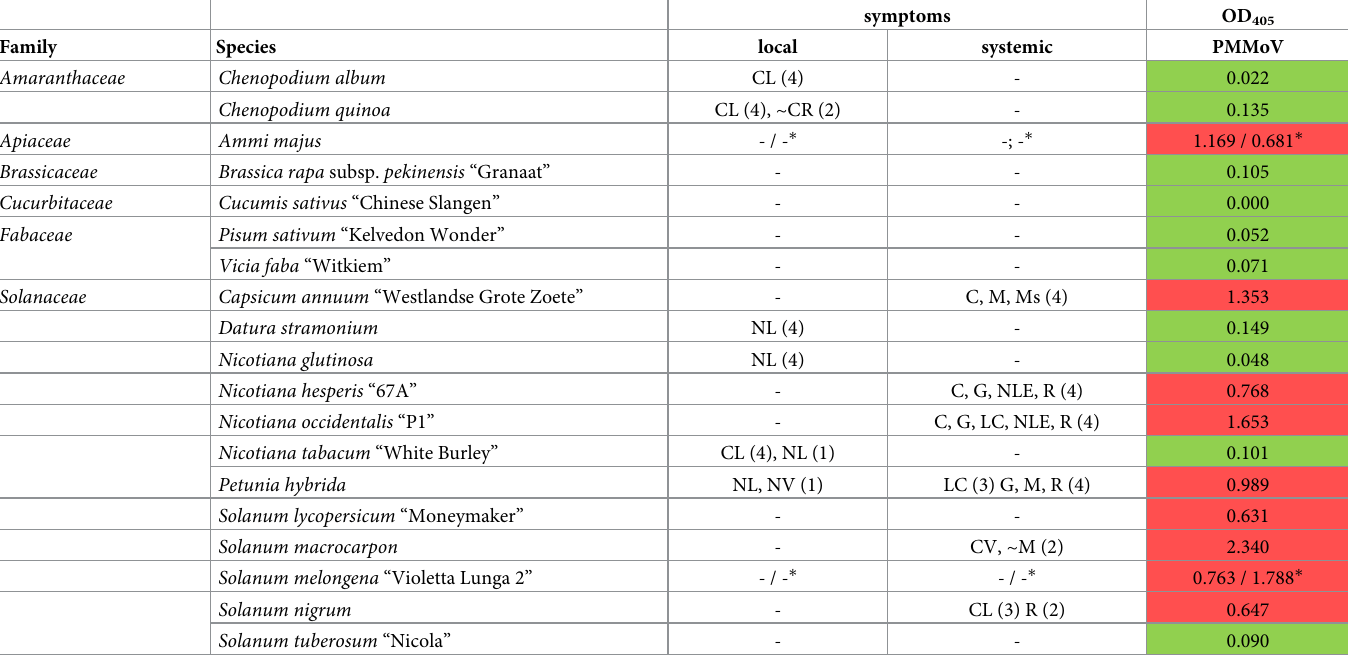
Table 3. Host range study: Symptomatology and DAS-ELISA results of test plants after inoculation with the novel